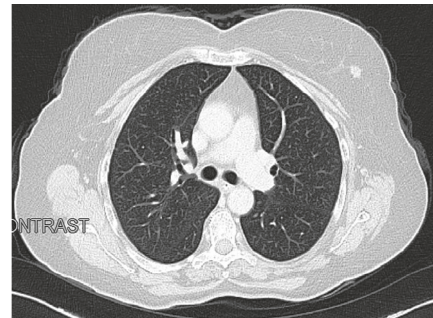
Figure 1: Thoracoabdominal